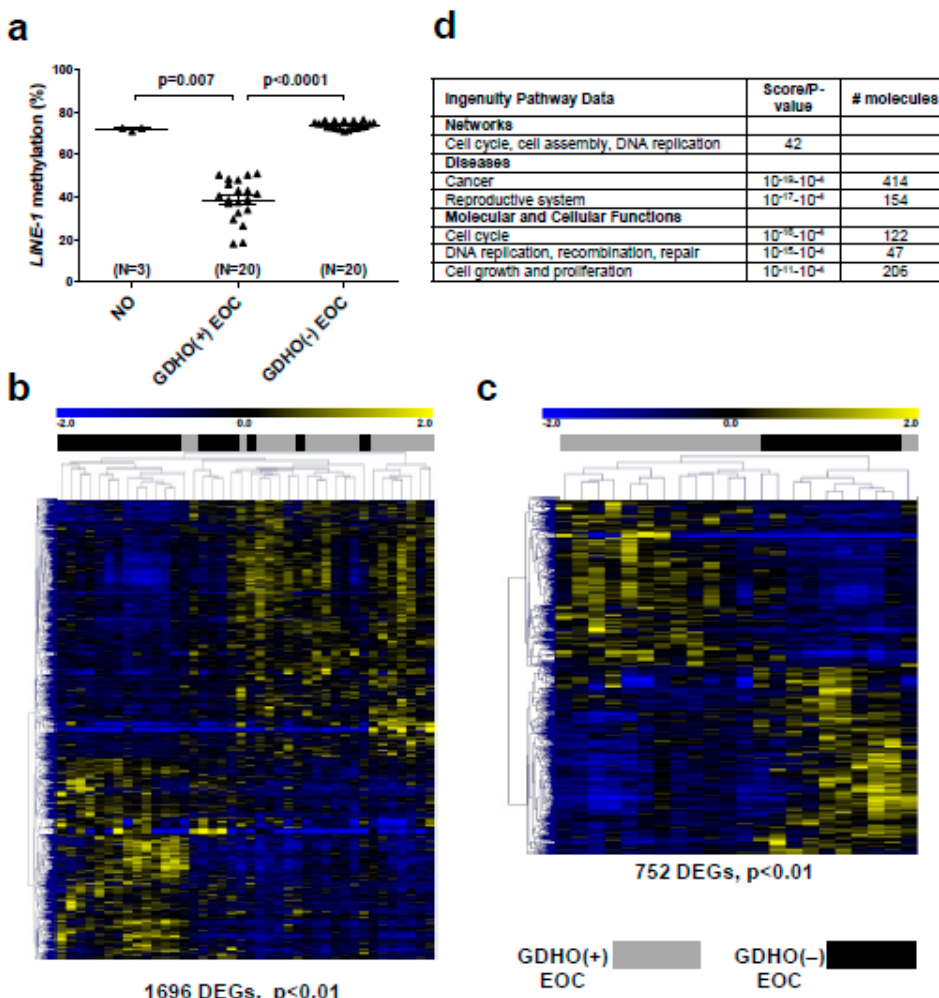
Figure 2. GDHO ( + ) EOC show distinct patterns of gene expression. ( a ) LINE-1 methylation in sample groups used for A ff ymetrix gene expression analyses: bulk normal ovary (NO), GDHO ( + ) EOC (i.e., LINE-1 hypomethylated group), GDHO (–) EOC (i.e., LINE-1 hypermethylated group). ( b ) Hierarchical clustering heat map of genes di ff erentially expressed (p < 0.01) between GDHO ( + ) vs. GDHO (–) EOC (all samples). ( c ) Hierarchical clustering heat map of genes di ff erentially expressed between disease-matched (age-matched, stage 3 / 4, grade 3, serous EOC) GDHO ( + ) vs. GDHO (–) EOC. All tumors correspond to the HGSOC subtype. The number of genes showing significant di ff erential expression in each comparison is indicated. Sample identities are indicated at top (see key). ( d ) Selected Ingenuity Pathway Analyses (IPA) data for the GDHO ( + ) vs. GDHO (–) EOC microarray